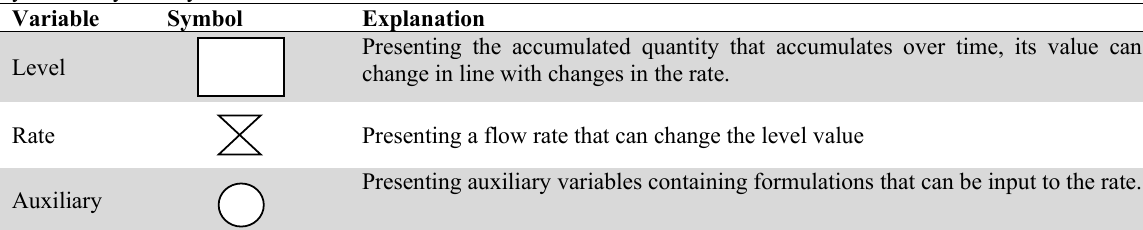
Symbol of system dynamics. Variable Symbol Explanation Level